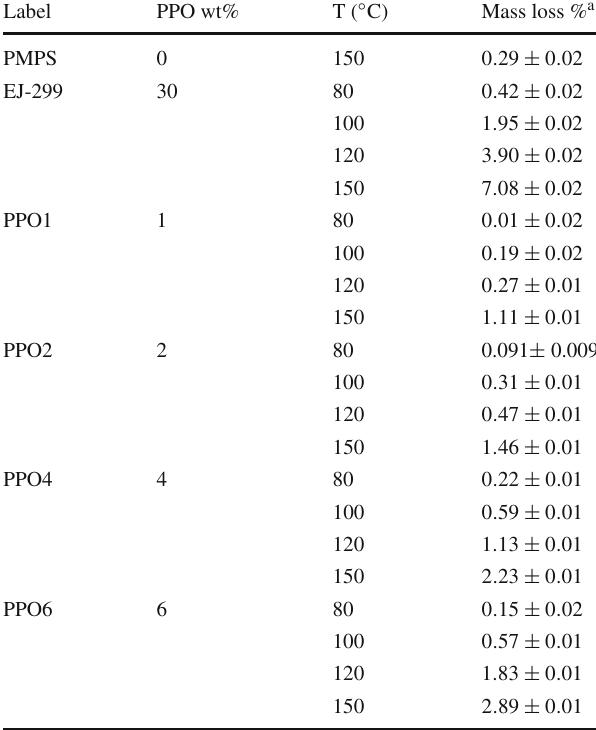
Table 1 Results of weight loss measurements on PMPS samples with different PPO concentration treated at selected temperatures